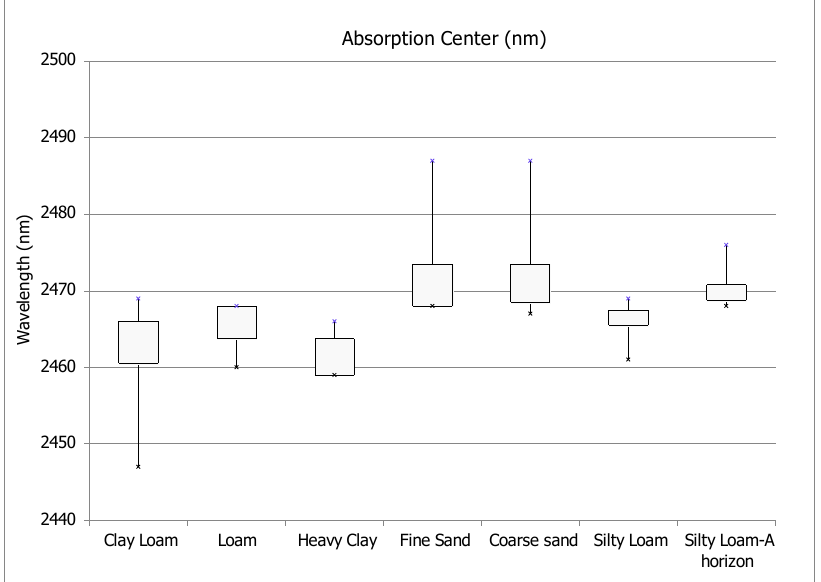
Figure 4. Variation in absorption feature parameters per soil textural type. Texture classes in dark grey contain highest clay content, lighter grey-highest sand content and the lightest grey- highest silt content: ( a) Absorption center, ( b) Absorption depth, ( c) Absorption